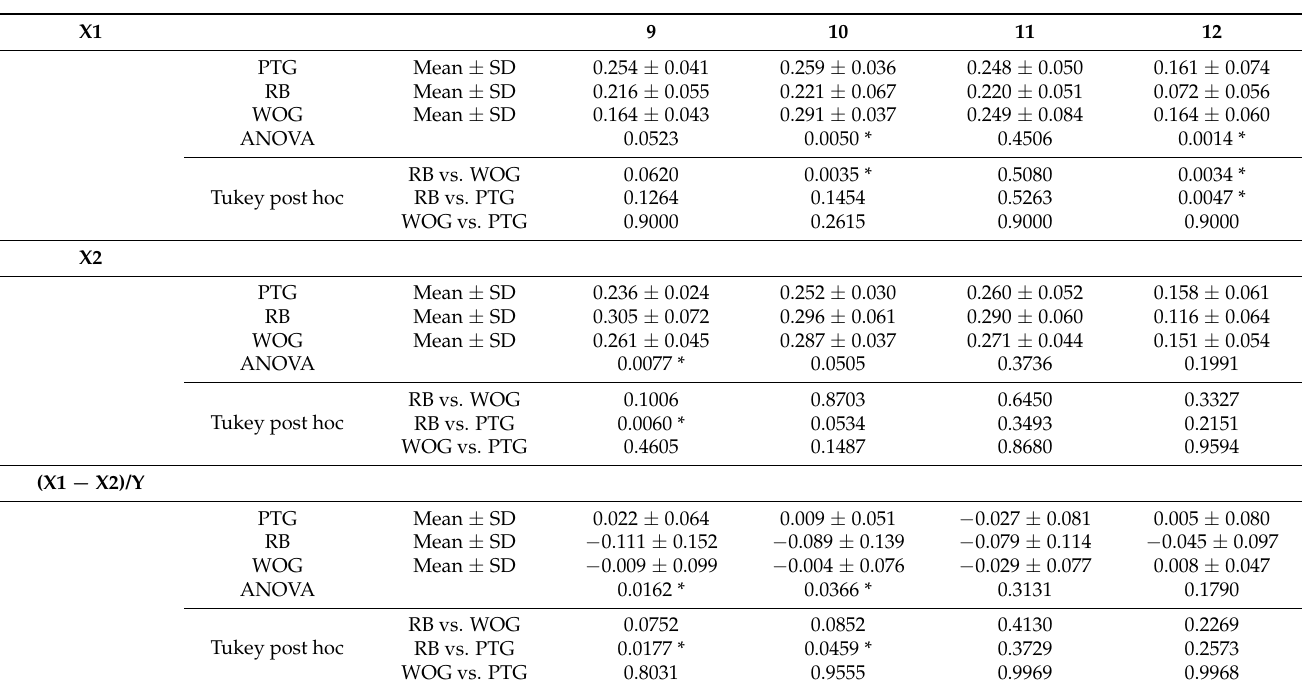
Table 3. X1, X2, and X1 − X2/Y mean value, standard deviation SD and ANOVA with Tukey’s post hoc test for the coronal